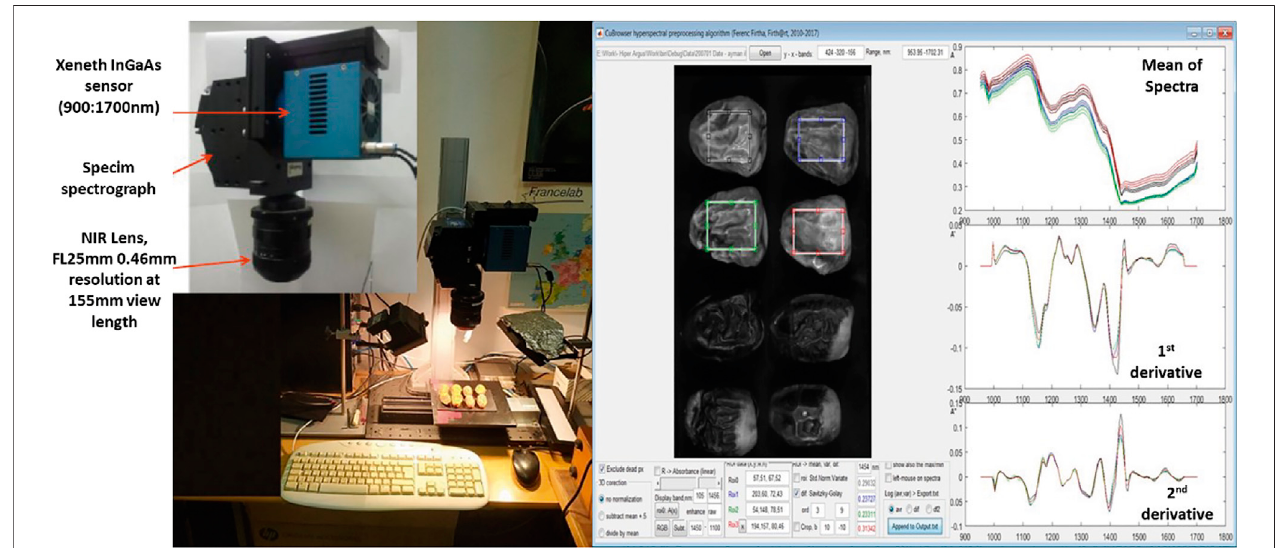
FIGURE 1 | Hyperspectral acquisition system and analysis of spectra of ROI for date samples.